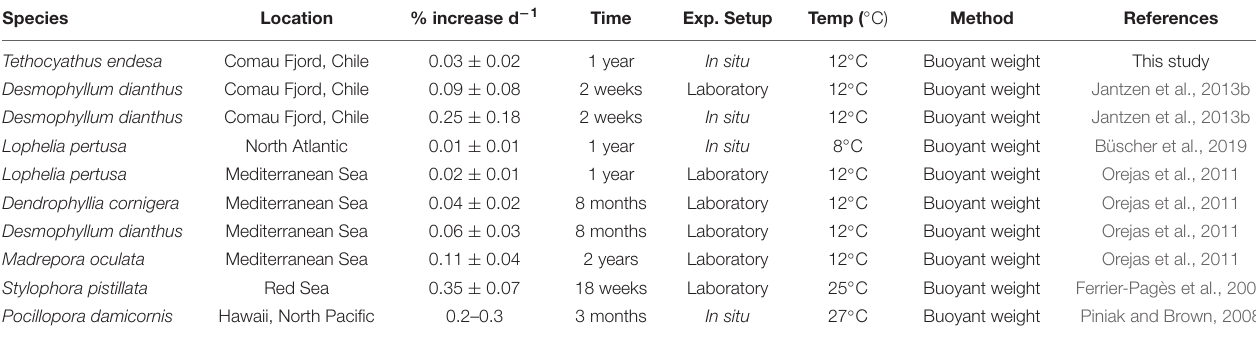
TABLE 2 | Comparison of skeletal growth (% increase per day ± SD) between different cold-water, temperate, and tropical/photosymbiotic coral species.